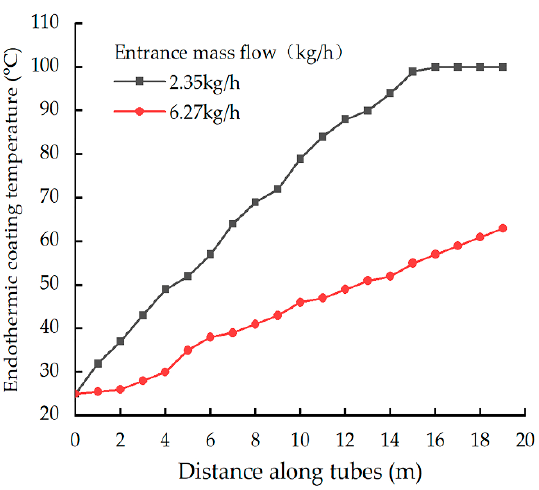
Figure 7. Measured temperature change of the endothermic layer.